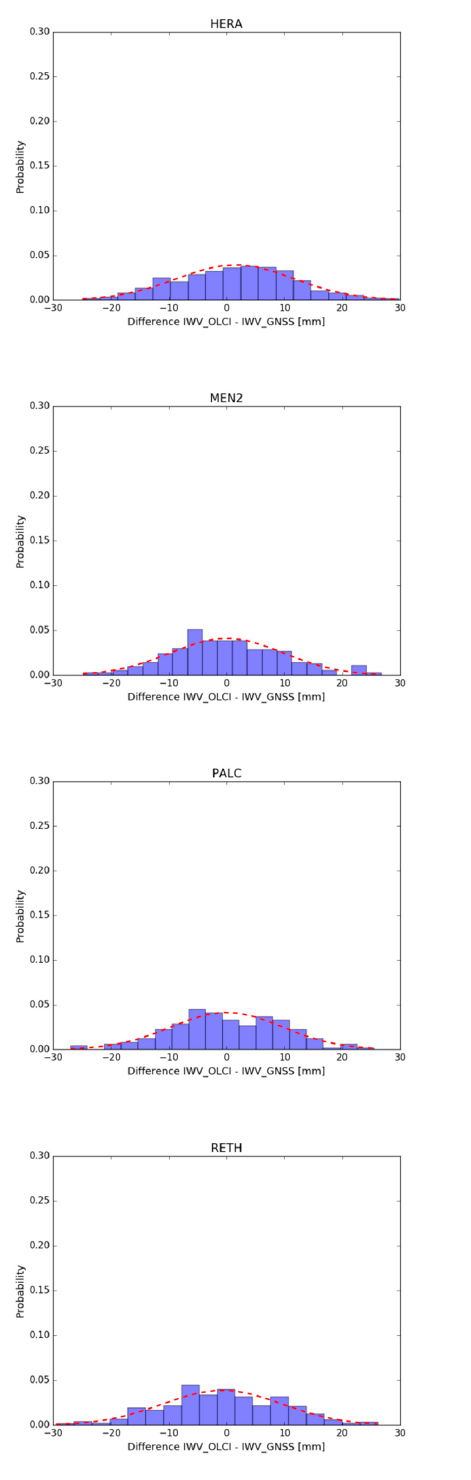
Figure 6. Histograms of the IWV value di ff erences, represented by the Sentinel-3A OLCI minus the IWV as determined by GNSS in ten GNSS stations over Crete. The red dashed line refers to the theoretical normal distribution for the data set of differences in IWV.